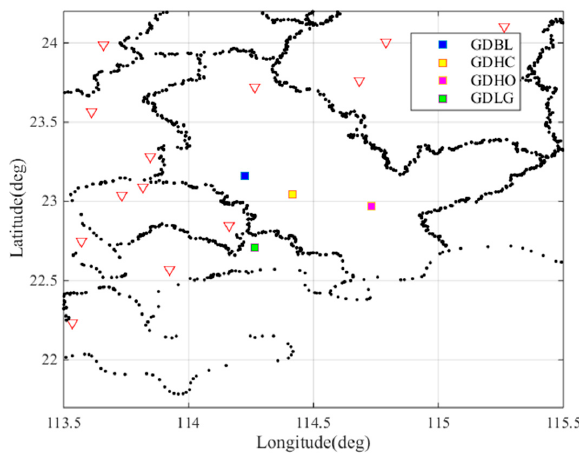
Figure 4. Locations of the nearby stations GDBL, GDHC, GDHO and GDLG.